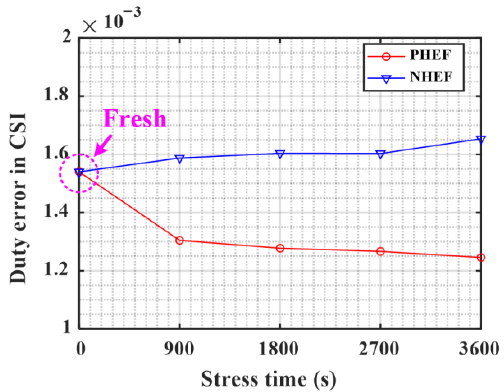
Figure 33. Duty error in CSI according to HEF stress time.